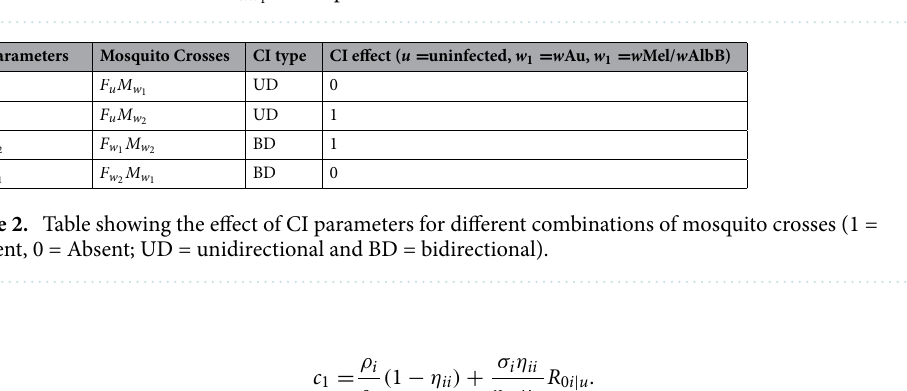
e w 1 equilibrium point